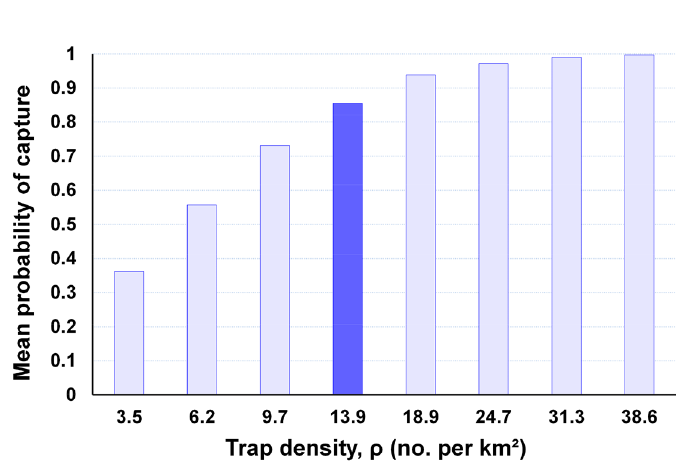
Figure 3. Mean probability of capture for the leek moth grid across different densities. The default density is shown by the dark blue bar.